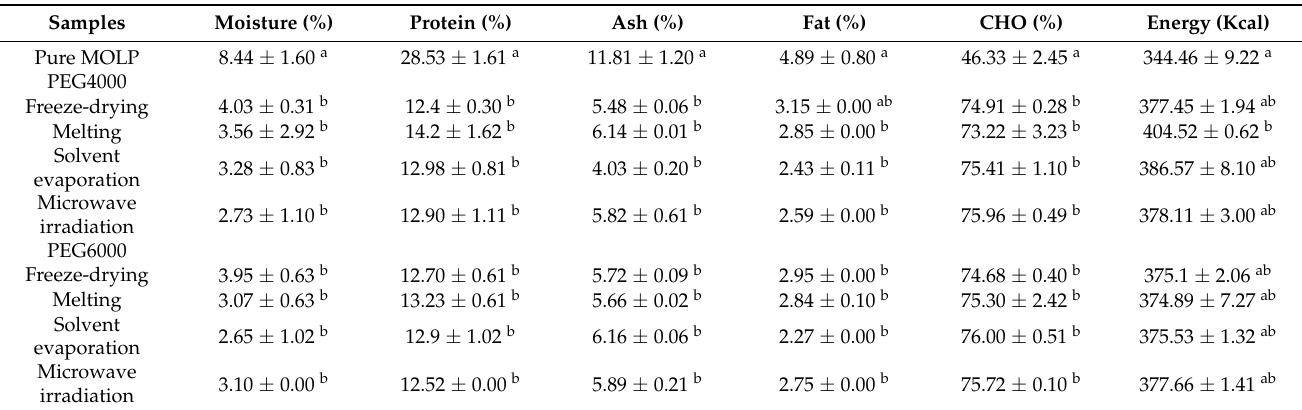
Table 1. The proximate compositions of pure Moringa oleifera leaf powder and solid dispersions of